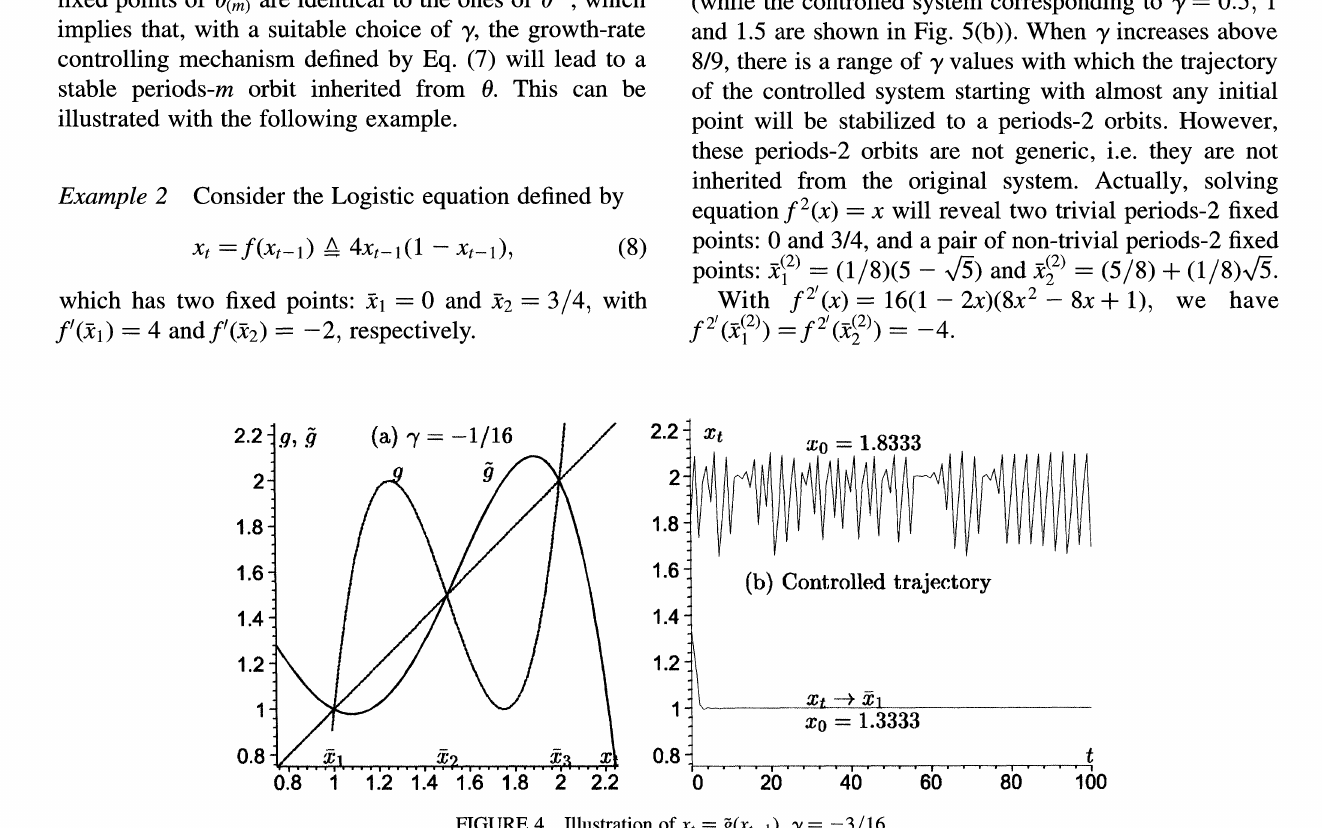
FIGURE 4 Illustration of